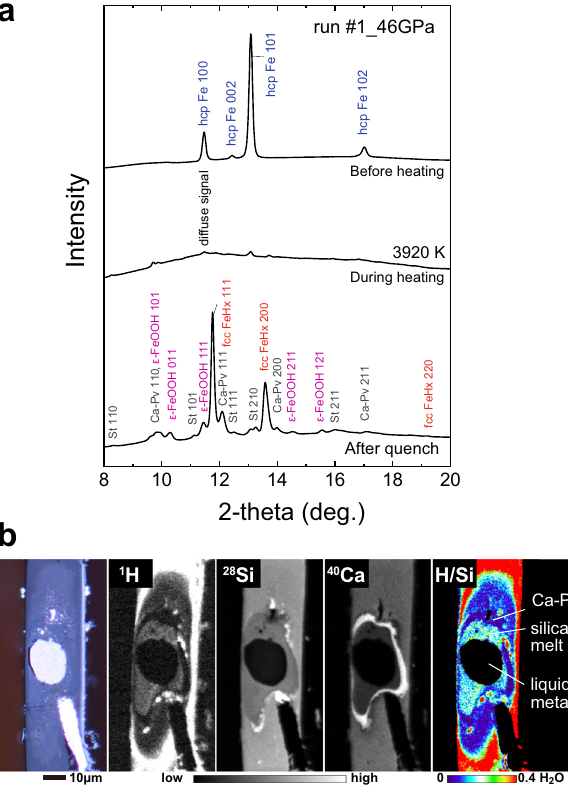
Fig. 1 Analyses of hydrogen in metal and silicate. a XRD patterns collected before/during/after heating to 3920 K at 46 GPa in run #1. Both iron and silicate were molten at the center of a laser-heated spot during heating. Hydrogen concentration in liquid metal was obtained from those in fcc FeH X and ε -FeOOH. b Photomicrograph (left), secondary ion images for 1 H + , 28 Si + , and 40 Ca + (middle), and a distribution map of water (right). Note the absence of hydrogen in metal because it escaped from iron upon releasing pressure. Hydrogen (water) content in quenched silicate melt was obtained with ±2% to ±7% relative